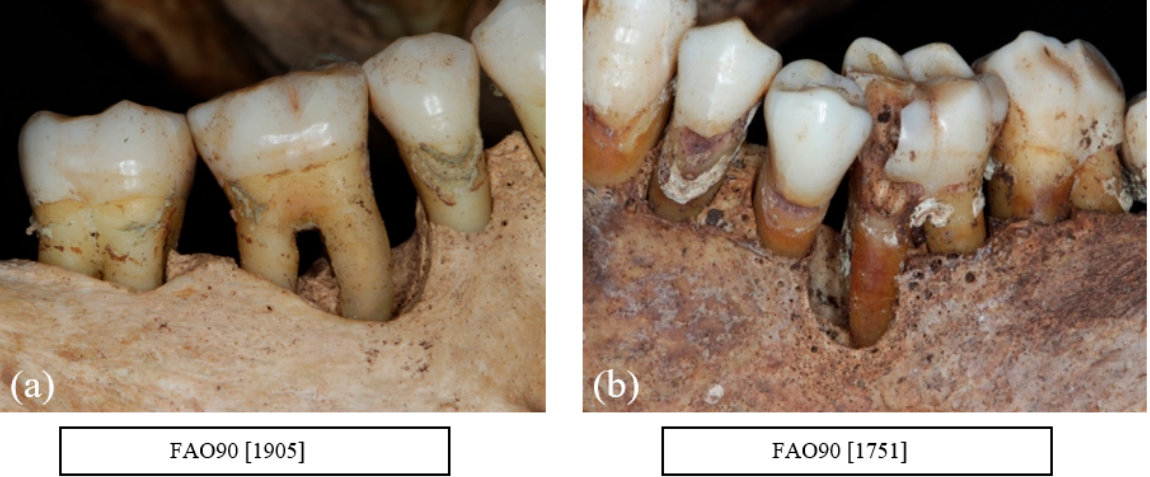
Figure 4. ( a ) FAO90[1905] Vertical bone loss mesial of a lower right mandibular first molar (LR6) with evidence of class III furcation involvement (courtesy of the Museum of London) and, ( b ) FAO90[1751] Vertical bone loss mesial of a lower left mandibular first molar (LL6) with a deep carious lesion and pulp exposure (evidenced by the defect around the exposed root) which could be associated with an endo-perio lesion (courtesy of the Museum of London).